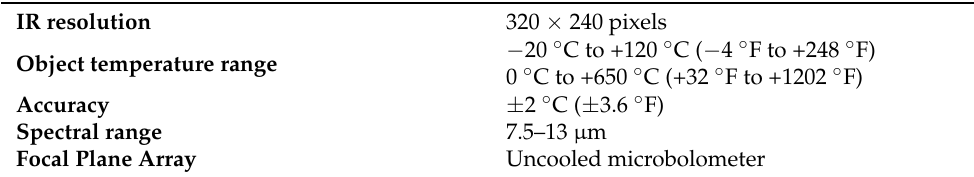
Table 1. Main technical specification of the employed thermal